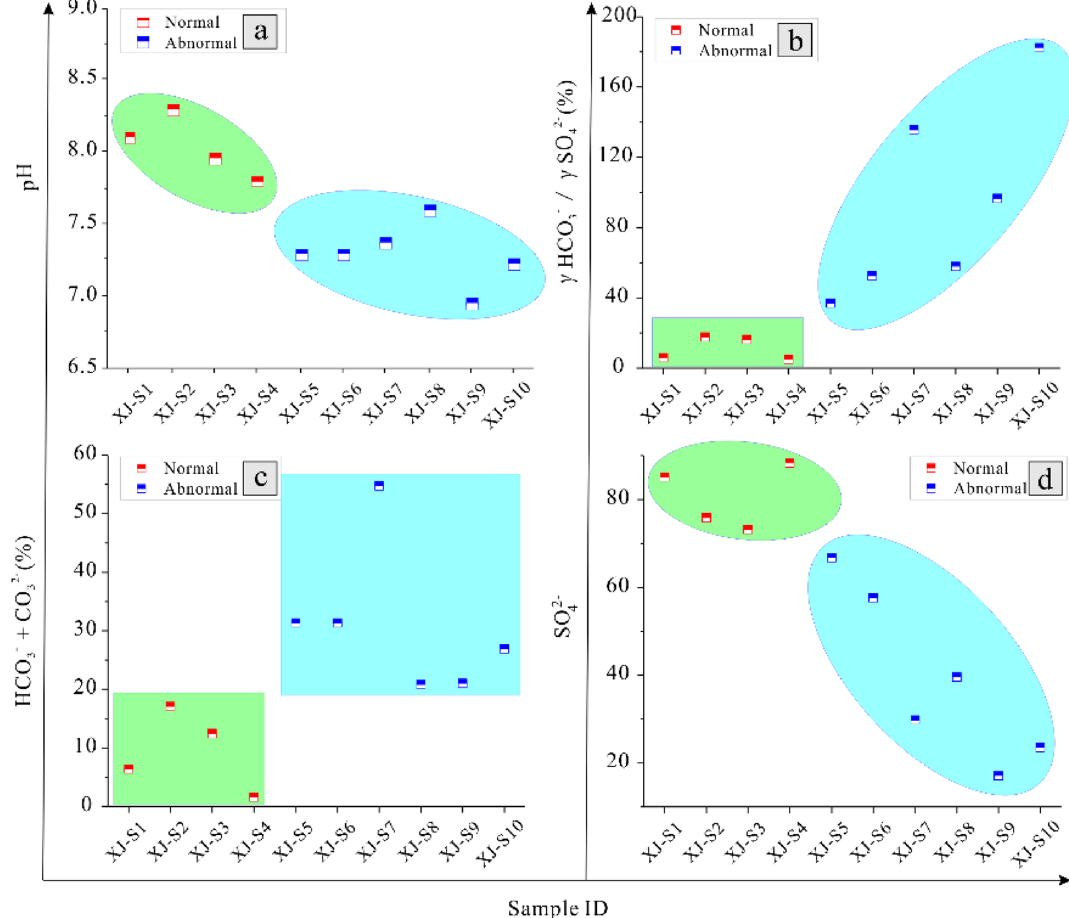
Figure 6. Correlation between groundwater geochemistry and H 2 S concentration. ( a ) The pH of samples, ( b ) is the value of